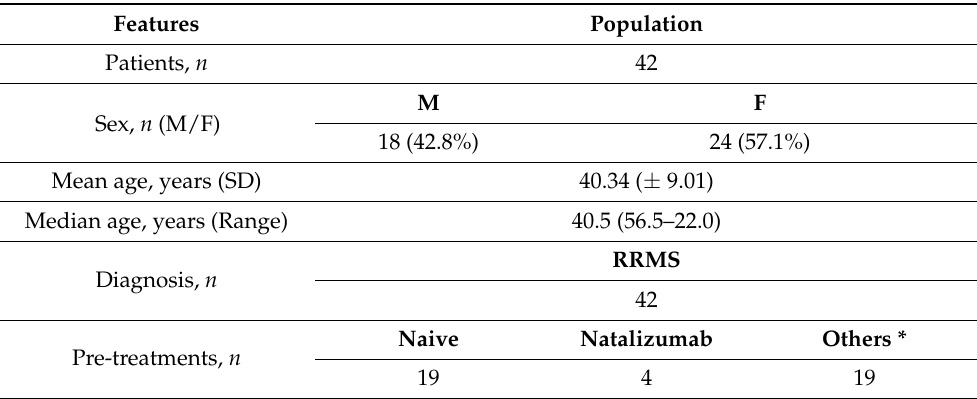
Table 1. Demographic and clinical characteristics of MS